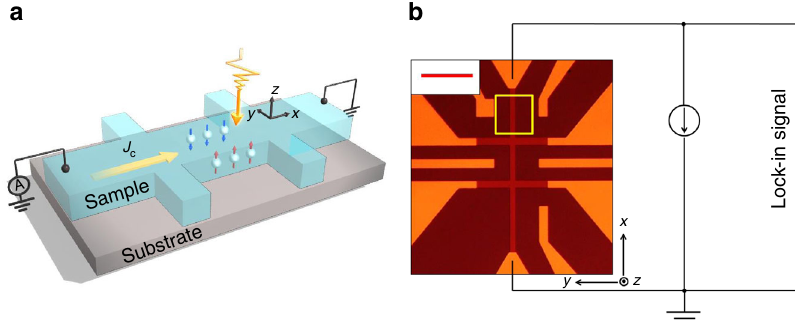
Fig. 1 Schematics of spin-dependent photovoltage generation and experimental setup. a Schematic of the device structure with bias current J c applied along the x direction. The laser is focused on the device with normal incidence. b Optical image of the device with a representation of the electrical connections. Scale bar is 50 µ m. The scanning area is indicated by a yellow box. The induced photovoltage is acquired by a lock-in ampli fi